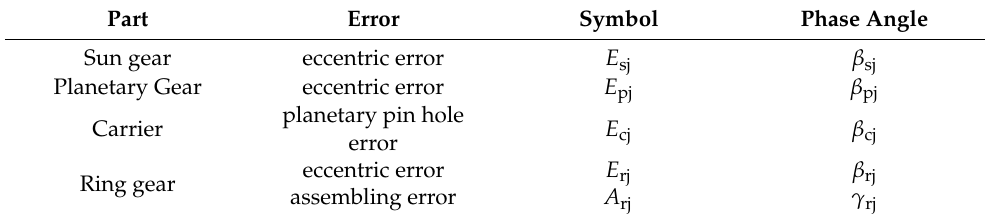
Table 1. Manufacturing and assembling error for the